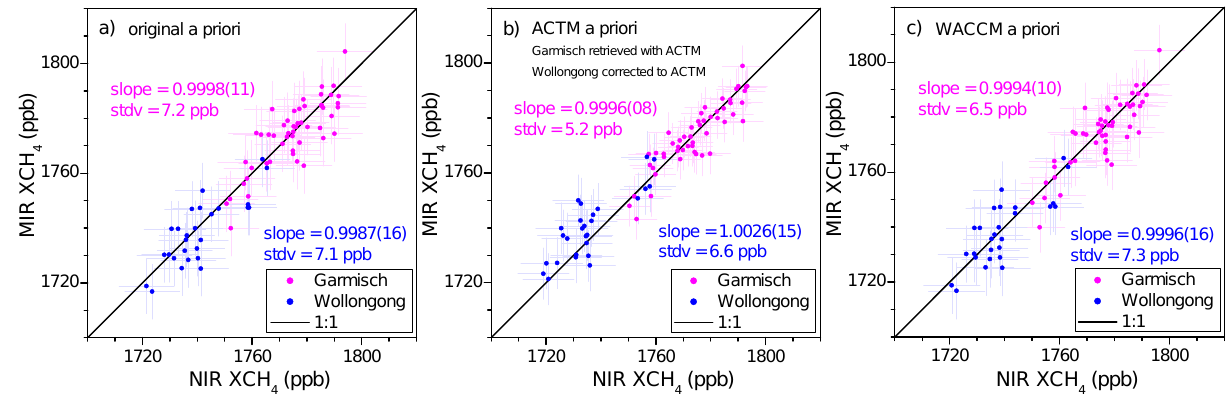
Fig. 4. (a) Scatter plot of MIR and NIR monthly means, both series retrieved with the standard retrieval a priori profile. Error bars on data √ points are 2- σ uncertainties derived from the stdv of the linear slope fit (2stdv/ 2). Uncertainties for the slopes are derived from the fit and are at 2- σ . (b) Same as (a) but using ACTM profiles as common prior. (c) Same as (a) but using WACCM profiles as common prior.